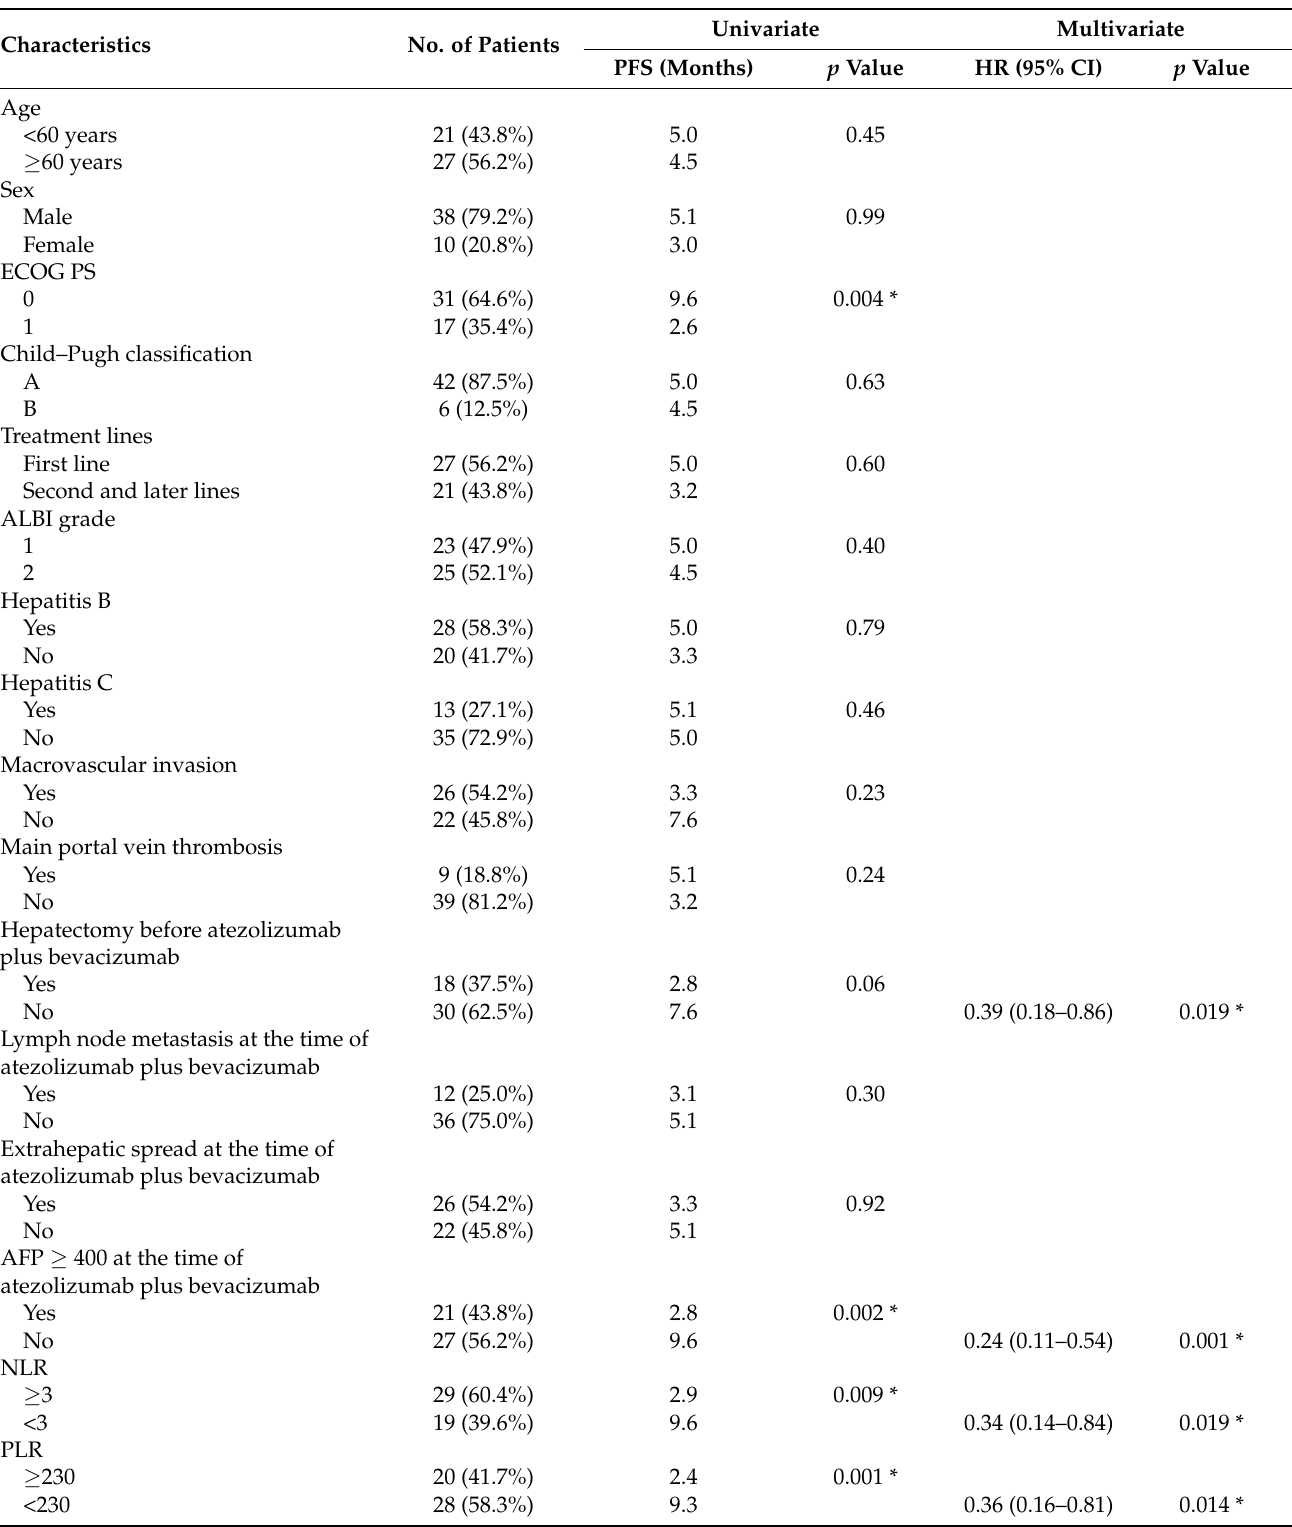
Table 3. Univariate and multivariate analyses of progression-free survival (PFS) in 48 patients